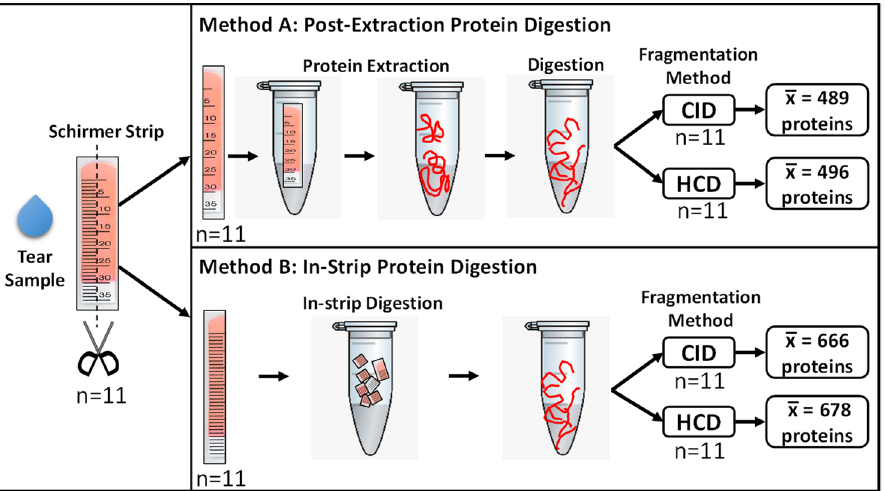
Figure 1. Comparison of two extraction methods (Method A and B) and two fragmentation methods (CID and HCD) for tear fluid processing. Tear fluid was collected using Schirmer strips ( n = 11), and each strip was cut longitudinally into two equal parts. In Method A, proteins were first extracted, and Schirmer strips were removed by filter-aided centrifugation prior to digestion. In Method B, Schirmer strips were cut into 5 mm pieces, and in-strip protein digestion was performed. Digested products from each method then underwent LC–MS/MS analysis using both collision-induced dissociation (CID) and higher-energy collisional dissociation (HCD) fragmentation techniques. The average number of unique proteins ( x̄ ) identified per sample using each workflow is displayed.